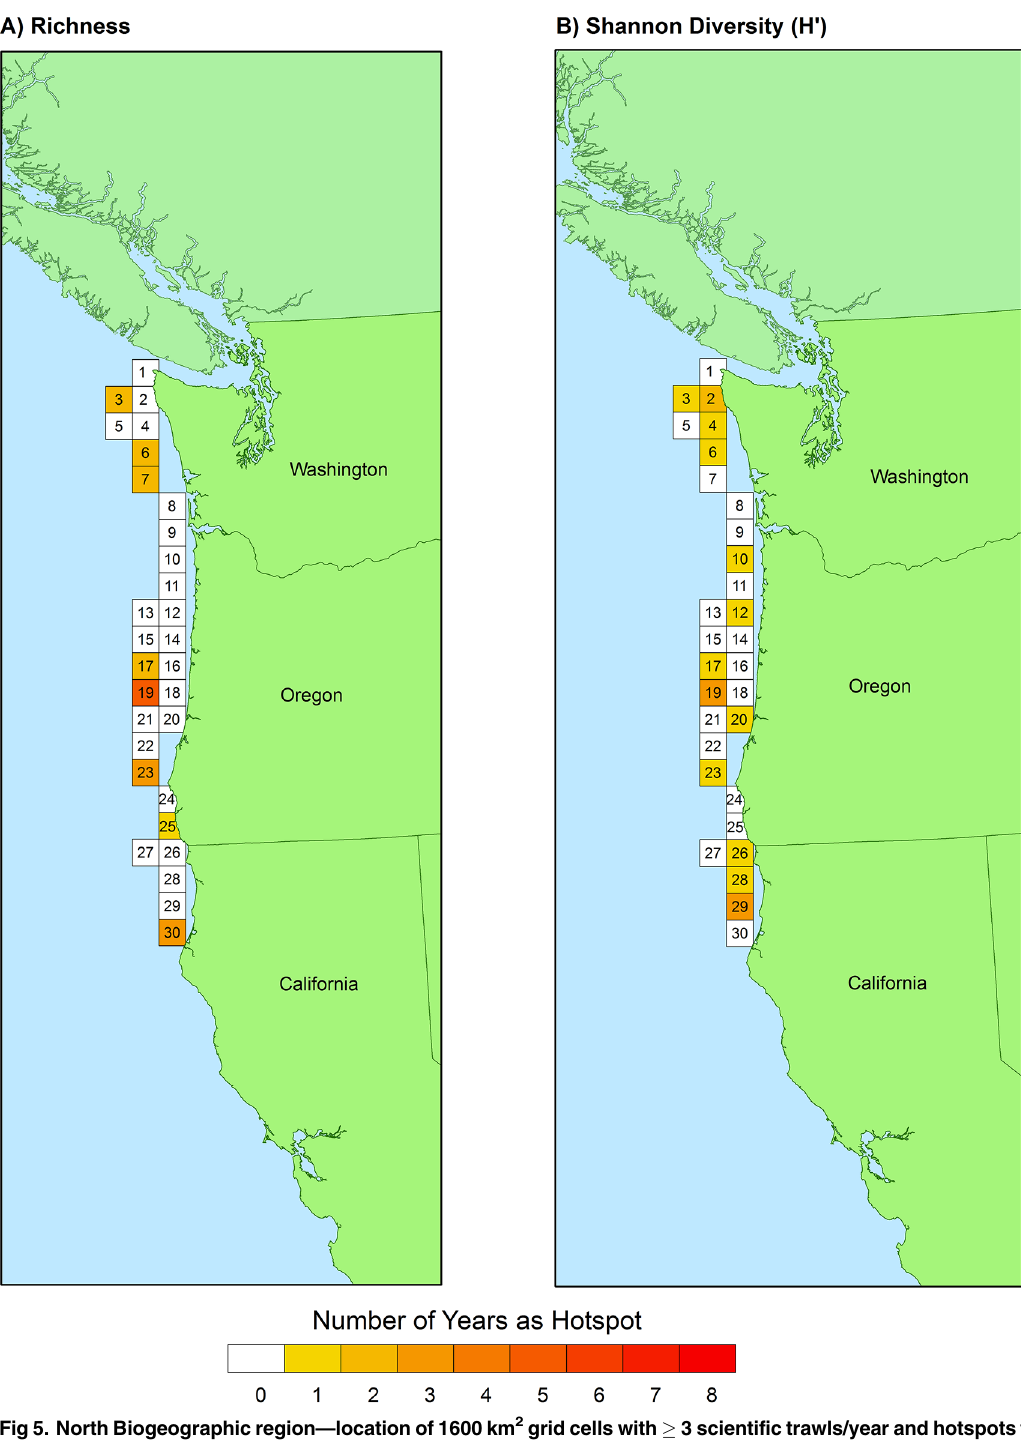
Fig 5. North Biogeographic region — location of 1600 km 2 grid cells with (cid:2) 3 scientific trawls/year and hotspots for A) benthic fish species richness, and B) benthic fish Shannon diversity, H 0 . Each grid cell contains an identification number and shading indicates the number of years (out of 8, 2003 – 2010) that the cell exceeded the universal threshold value to be classified as a hotspot (31.1 for species richness, 2.37 for Shannon diversity H 0 ).